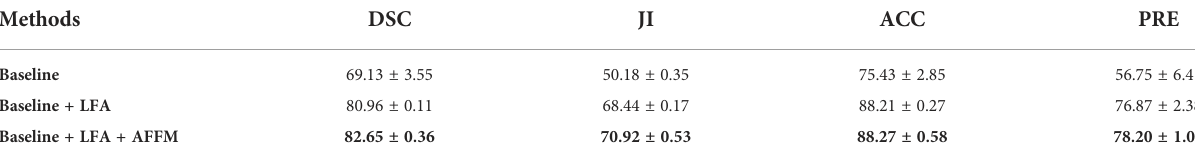
TABLE 3 Ablation study of the GCLDNet method on the SEED dataset.